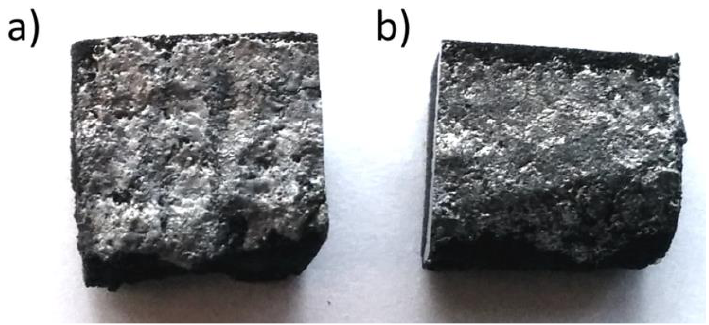
Figure 18. Post-processed Inconel 625-coated parts prepared though the ESAM process using the following parameters: ( a ) 600 mJ, 120 μF, and ( b ) 400 mJ, 80 μF after binder jetting